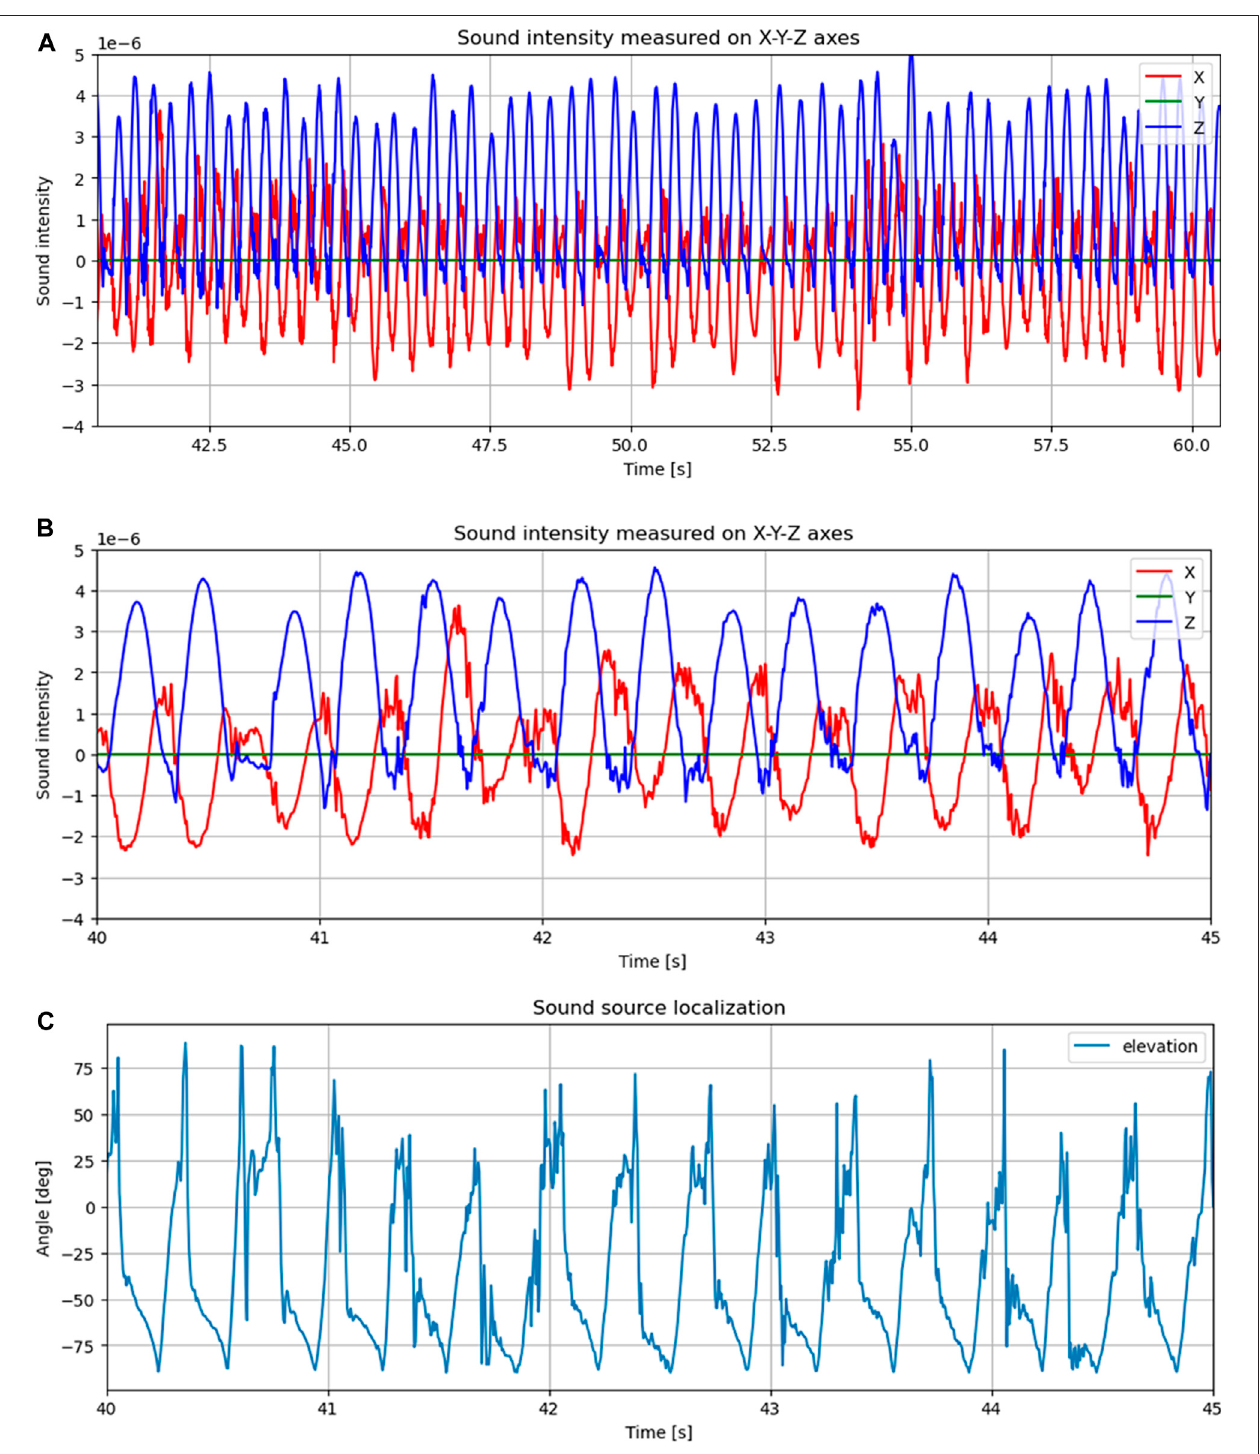
FIGURE 4 | Acoustic intensity: (A) measured in directions X and Z, (B) enlargement of the fragment of the upper diagram, (C) the course of the elevation angle calculated from the intensity signals in the X and Z axes.